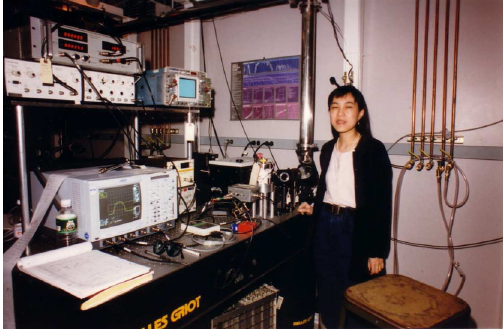
FIG. 8. Photograph showing Teng Chen and the instrumenta- tion she used to measure the fluctuations in the 9th coherent spontaneous harmonic of the MkIII FEL as it approached saturation in